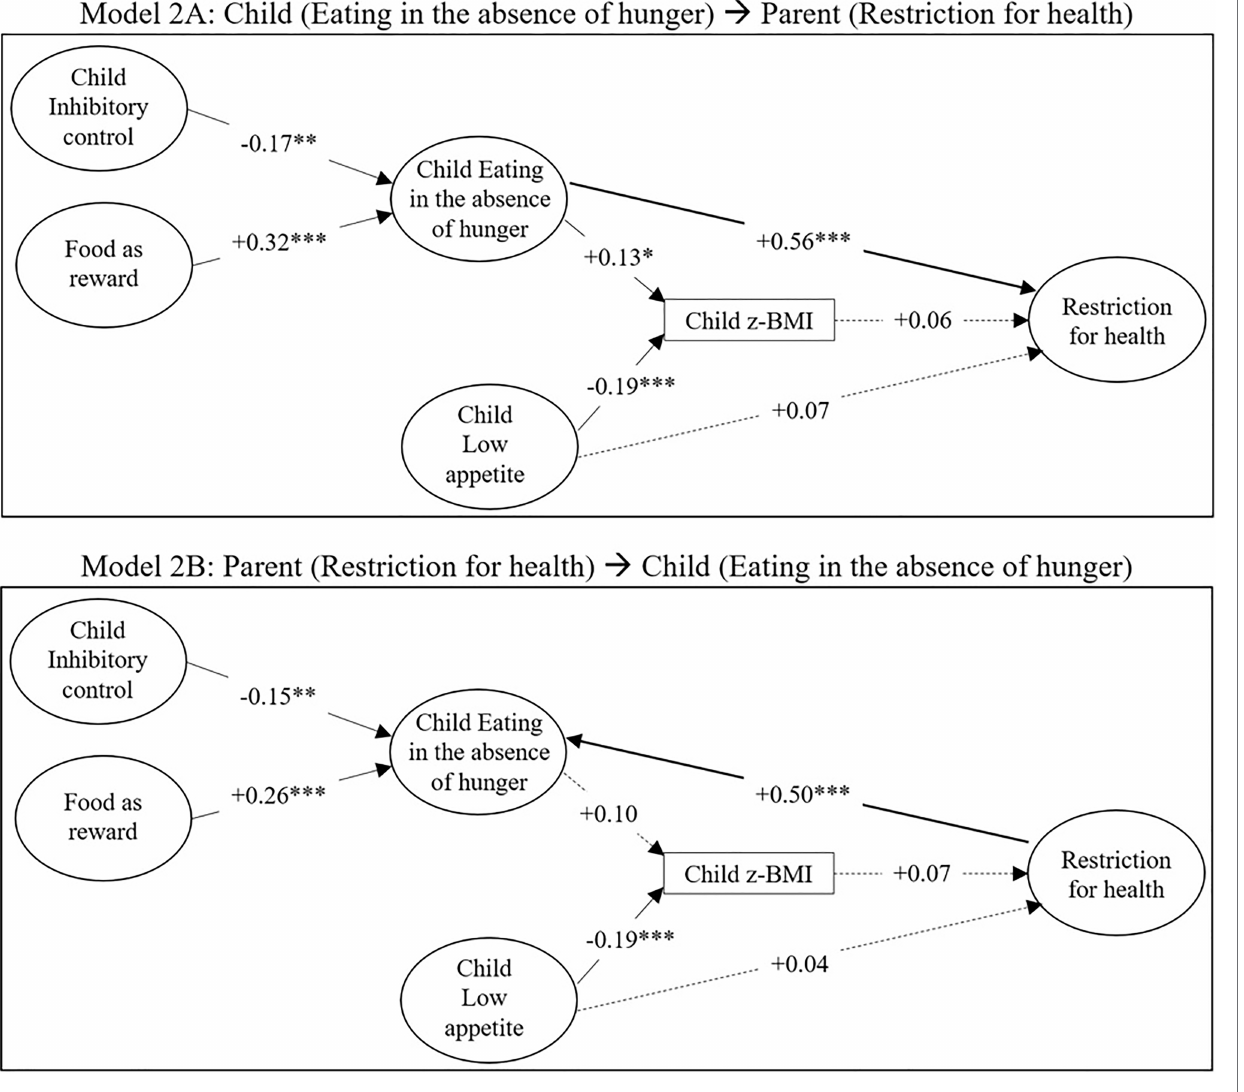
FIGURE 3 | Structural models for the associations between parental feeding practices (restriction for health, food as reward), child inhibitory control, child EAH, child low appetite and child BMI z-score. Numbers indicate standardized coefficients, solid lines indicate significant coefficients (* p < 0.05; ** p < 0.01; and *** p < 0.001), and dashed lines indicate non-significant coefficients. The correlations between the exogenous latent variables (food as reward, inhibitory control, low appetite) are not visualized here. Model 2A: model from child’s EAH to mother’s restriction for health. Model 2B: model from mother’s restriction for health to child’s